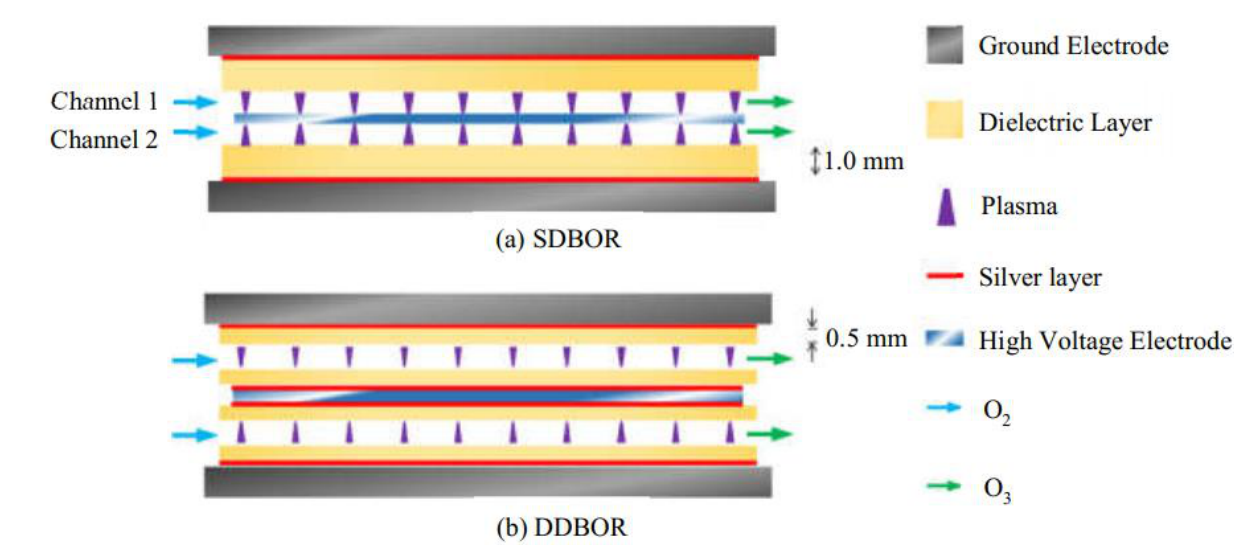
Figure 2. Internal structure of dielectric barrier discharge with silver layer (SL-DBD) reactor with double channel. ( a ) a single dielectric-barrier ozone reactor (SDBOR); ( b ) double dielectric-barrier ozone reactor (DDBOR).